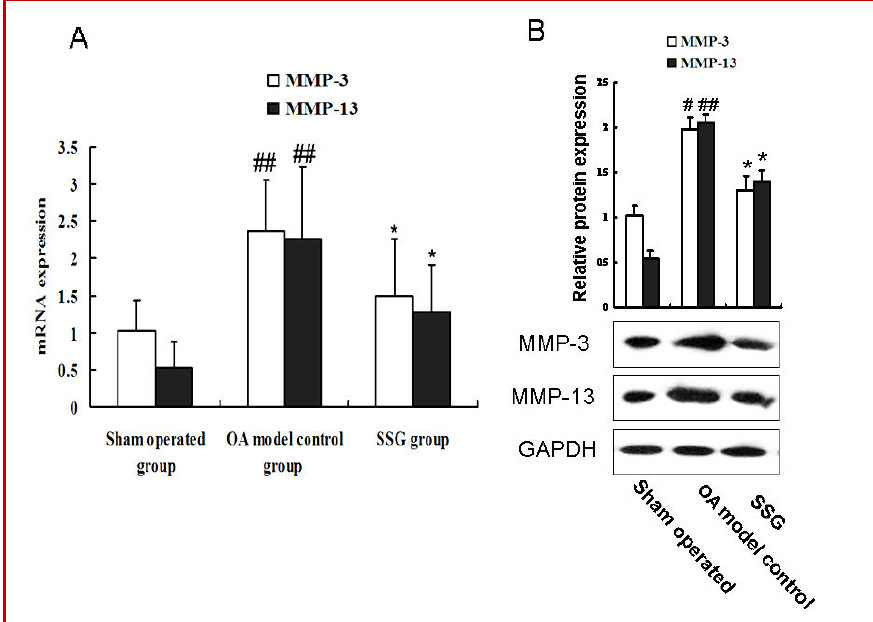
Figure 3: The mRNA and protein expression levels of MMP-3 and MMP-13 were determined by RT-PCR (A) and western blot (B)